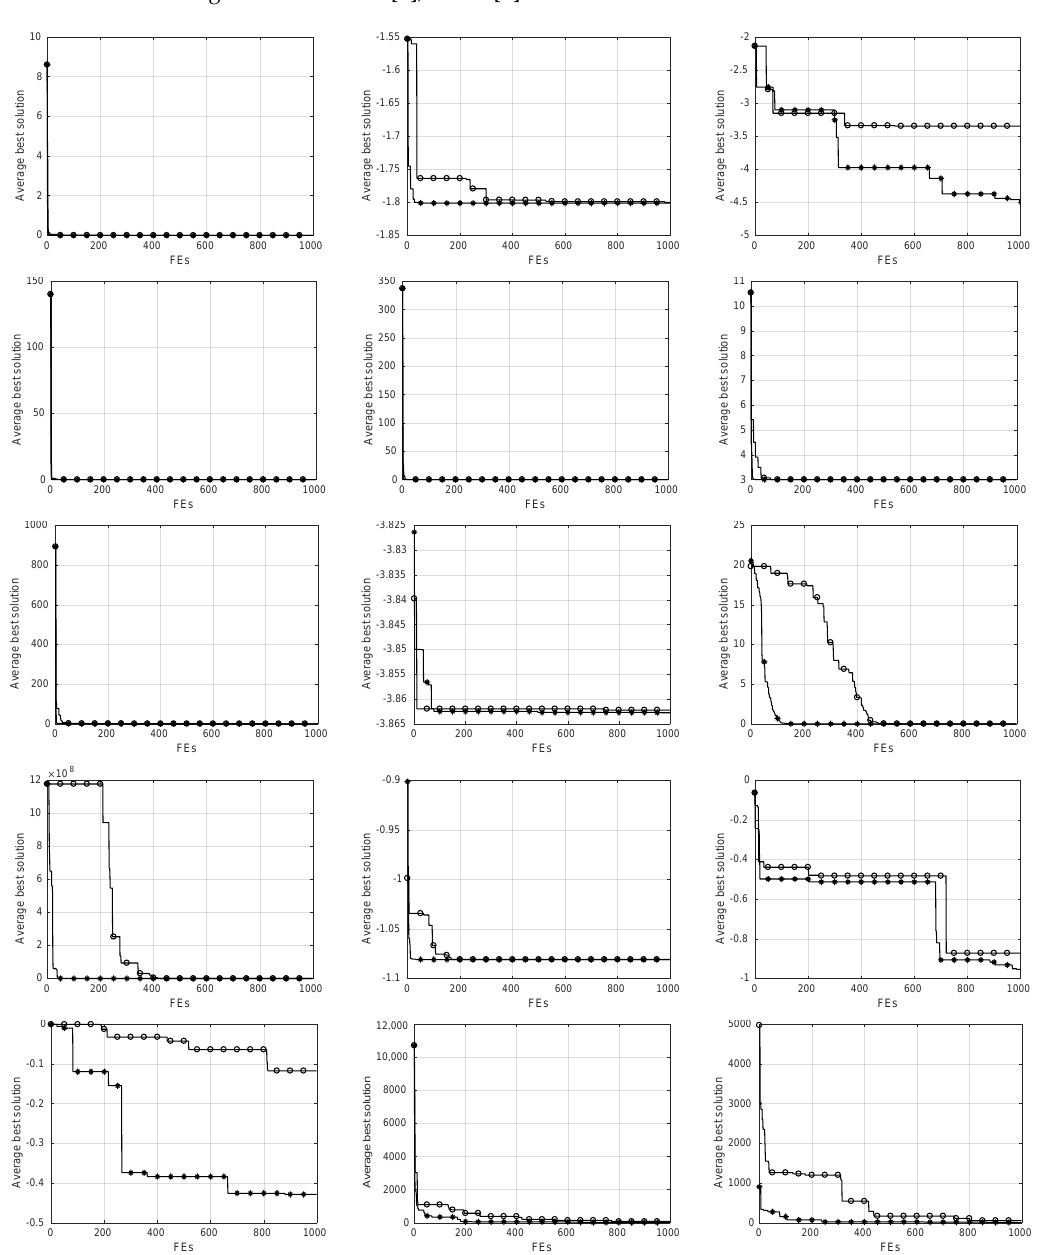
Figure 14. Convergence curves for the benchmark functions f 16 − f 30 in row-major order. Optimiza- tion algorithms are SCA [ ◦ ], ESCA [ ∗